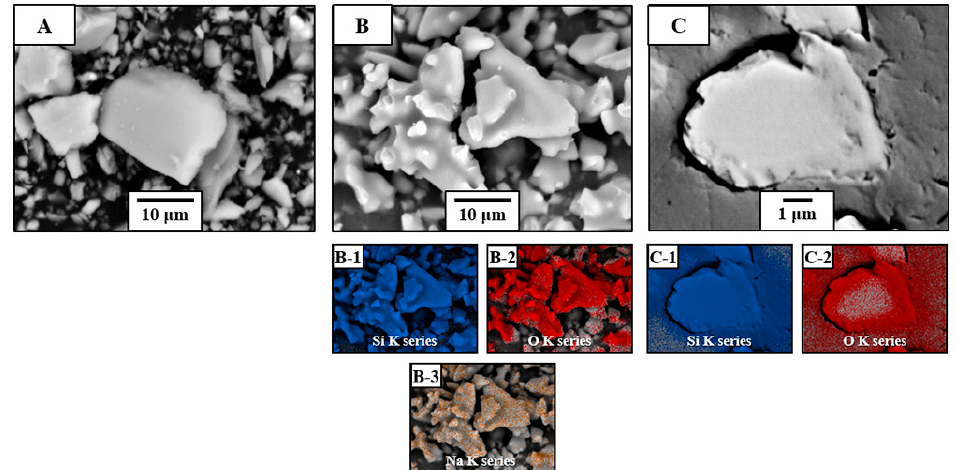
Figure 3. Powder morphology and component distribution of healing agent: ( A ) normal Si powder, ( B ) Si powder encapsulated by a binary system, and ( C ) magnified cross section of Si powder encapsulated by a binary system. Each number indicates energy dispersive spectrometer (EDS) mapping results of Si ( B-1 , C-1 ), O ( B-2 , C-2 ), and Na ( B-3 ), respectively. Coatings 2019 , 9 , x FOR PEER REVIEW